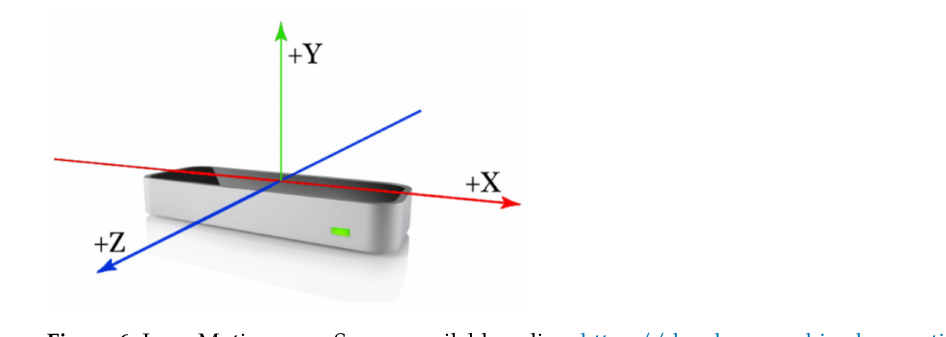
Figure 6. Leap Motion axes. Source available online: https://developer-archive.leapmotion.com/